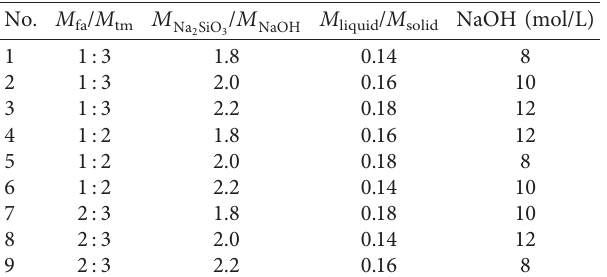
Figure 2: The typical geopolymer sample made by two methods. The same percentage of material in proportions is used for these two methods, except that 18% more water is added for casting method in order to make the raw materials able to be poured into the mold: (a) made by casting method; (b) made by pressing mold method. Table 2: The details of uniaxial protocol for orthogonal experi- mental